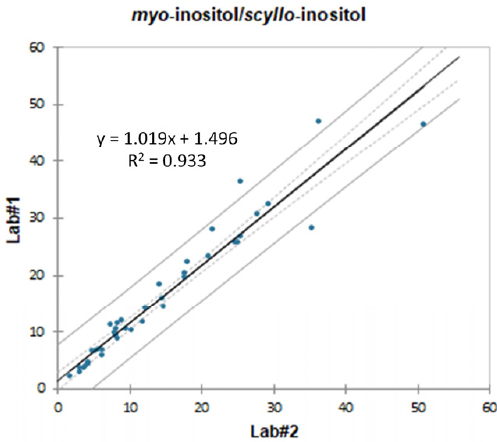
Figure 2. Comparison of the myo -inositol/ scyllo -inositol ratio calculated for the 40 comparison samples by each of the two laboratories. The solid grey lines are the confidence limits for the prediction (95%), while the dotted grey lines are the confidence limits for the regression line (95%).